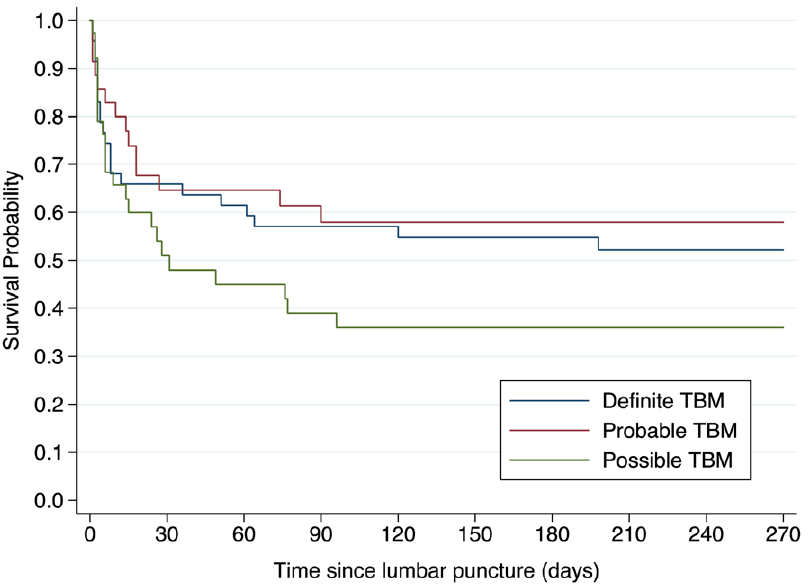
Figure 2. Kaplan-Meier survival curves of patients with definite, probable and possible tuberculous meningitis (TBM). Survival probability at 6-months was similar between patients with definite TBM and those with probable TBM (log-rank test p=0.69), and possible TBM (log- rank test p=0.15).